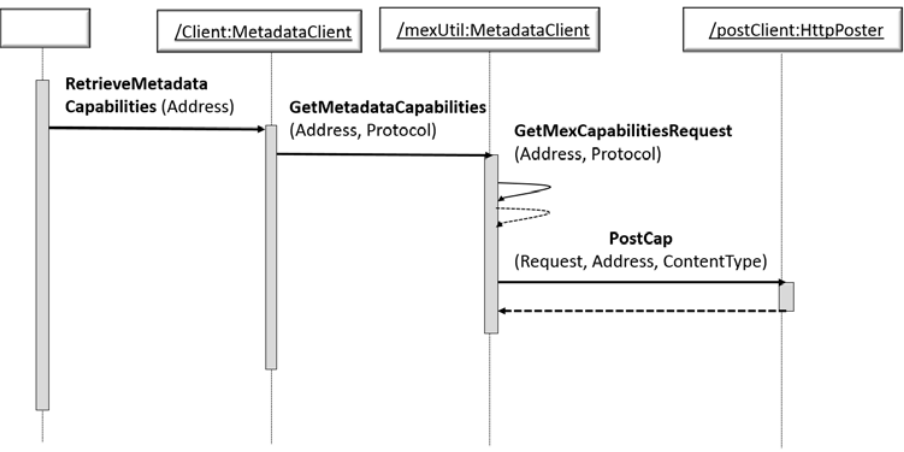
Figure 4. Classes and methods involved in the metadata retrieval phase. Table 2. Java classes of the client package affected by the changes.